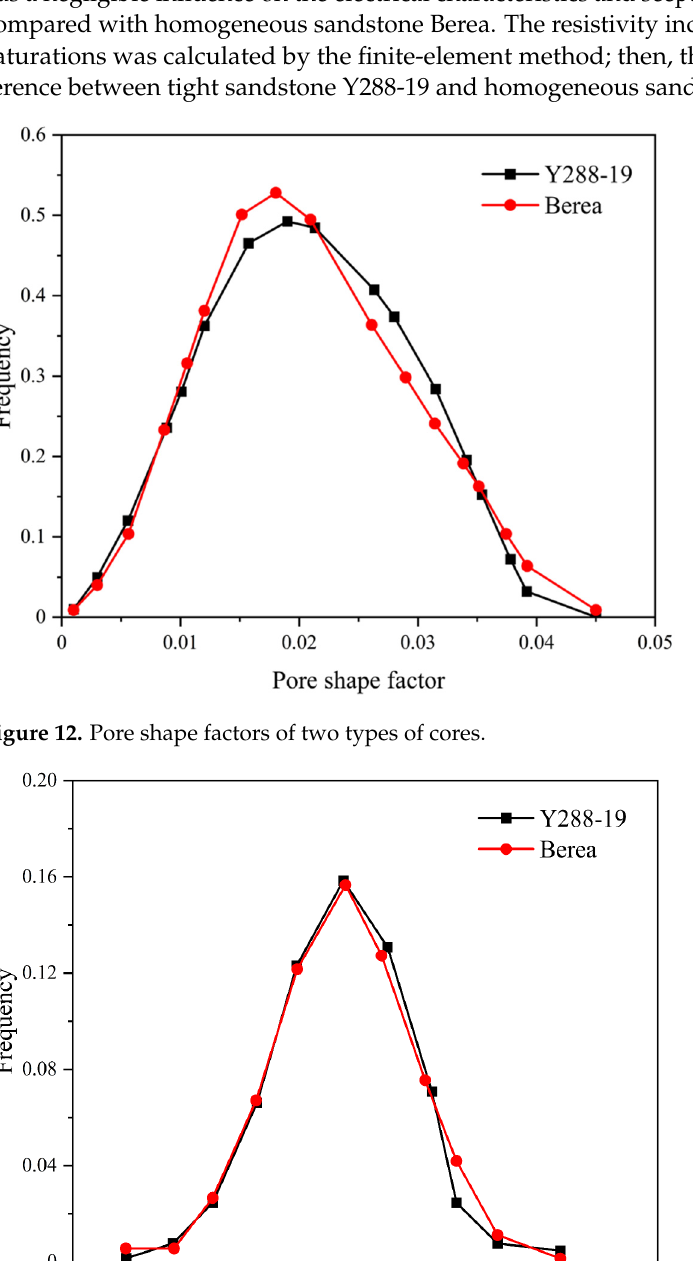
Figure 14. I-Sw curves of the two types of cores. For the digital rocks, Y288-19 and Berea sandstone, different oil saturations corre- sponding to different pressures are obtained by applying different pressures to simulate the process of oil and water displacement, then the capillary pressure curve is obtained. The capillary pressure curves of the two types of cores are shown in Figure 15 below. It can be seen from the figure that the displacement pressure of tight sandstone Y288-19 is 0.0235 Mpa. When the displacement pressure is reached, the non-wetting phase passes through the maximum connecting pore throat. Due to the complex pore structure of tight sandstone, the invading non-wetting phase is unevenly distributed in the pore throat. The non-wetting phase has little effect on the rock resistivity, especially when it invades par- allel macro-pores. At this time, the increased rate of resistivity index I is slow. As the non- wetting phase continues to invade the pore space, especially when pores are connected in series, the rock resistivity increases rapidly, and resistivity index I also increases. When the capillary pressure breaks through the displacement pressure, the non-wetting phase